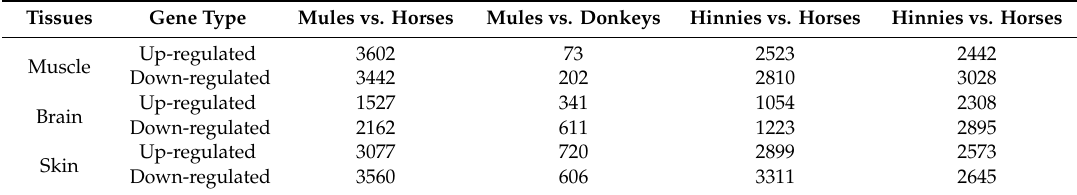
Table 1. Distribution of DEGs across muscle, brain, and skin tissues of mule, hinny, and their parents. Tissues